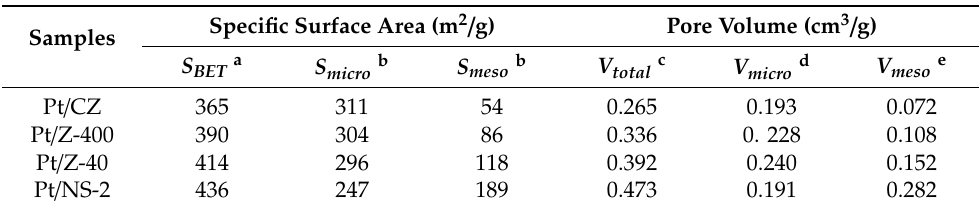
Table 2. Textural properties of di ff erent Pt-loaded zeolite